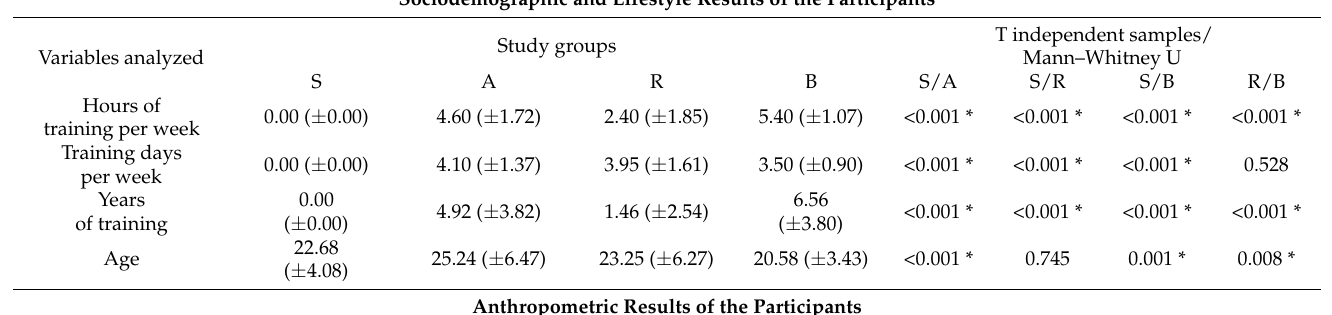
Table 2. Sociodemographic, lifestyle, and anthropometric results of the participants. S = persons without sport activity, A = persons with non-professional sports activity, R = runners, B = basketball players, A/S = persons with non-professional sports activity/persons without sport activity, S/R = persons without sport activity/runners, S/B = persons without sport activity/basketball players, B/R = basketball players/runners, * = statistically